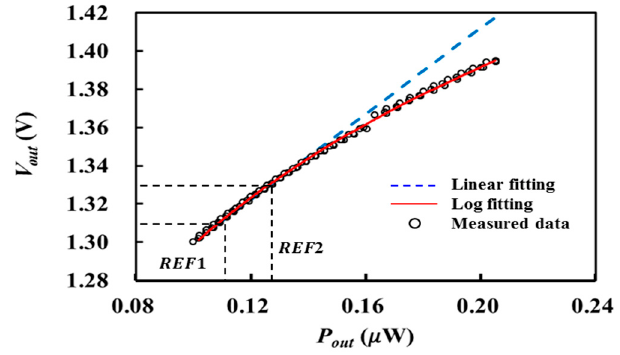
Figure 2. Measured characteristics of the logarithmic detector.